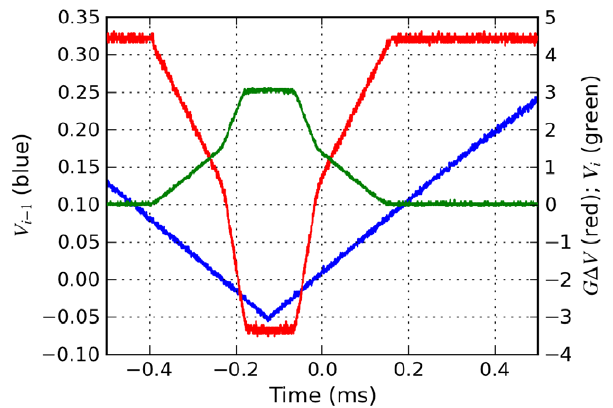
Figure 3. Measured time response of single gene circuit. Time response for the single gene circuit in Fig. 1 with V th =0 and C i =0. Input V i-1 (blue), op-amp output G D V (red), final output V i (green). The red curve shows saturation of the op-amp output at + 4.5 and –3.5 V when using a + /–5 V supply. The change in slope when V i-1 = V th is also apparent.